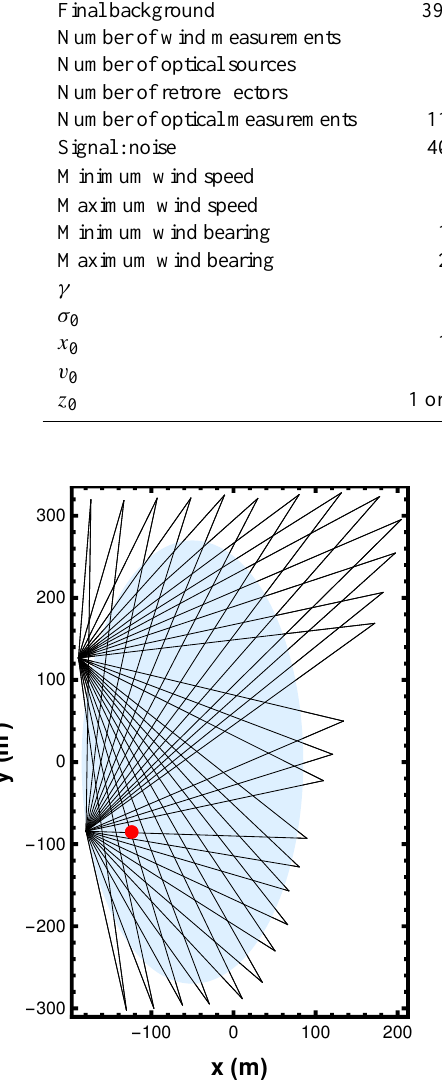
Figure 1. The lines of observation in both the experiment and the simulation are shown here, with up being north and right being east. Each of the two light sources starts 27 line segments which end on each of the 27 reflectors. The pale blue ellipse represents the region in which carbon dioxide sources were simulated. The red dot repre- sents the position of the leak found in the experiment as calculated by maximizing the likelihood using the Ermak plume